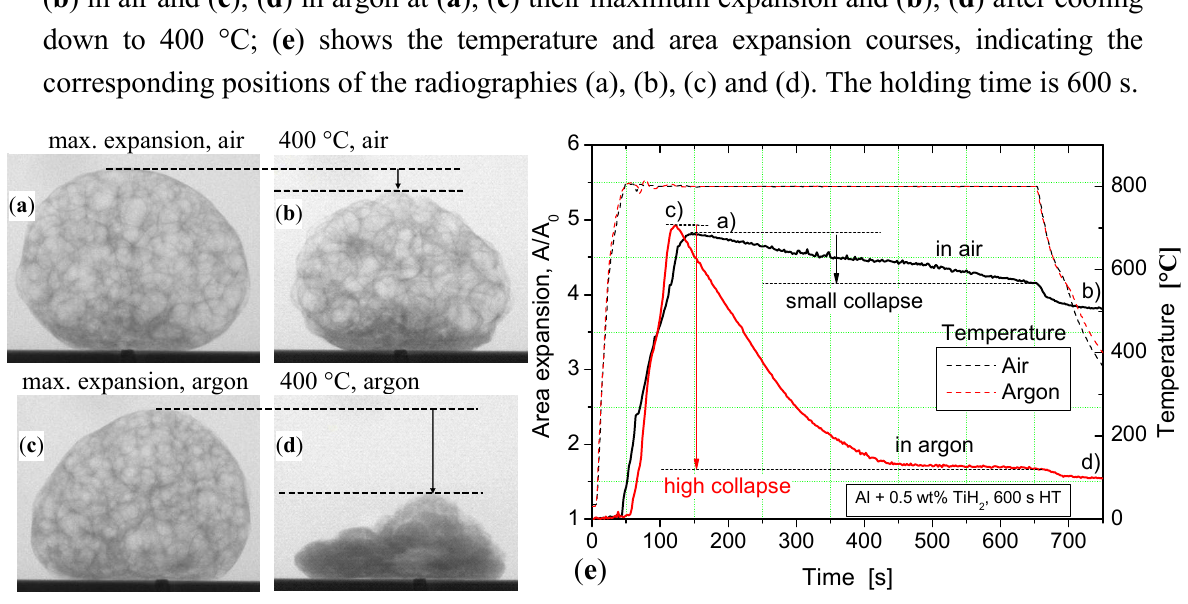
foams produced ( a ); 2